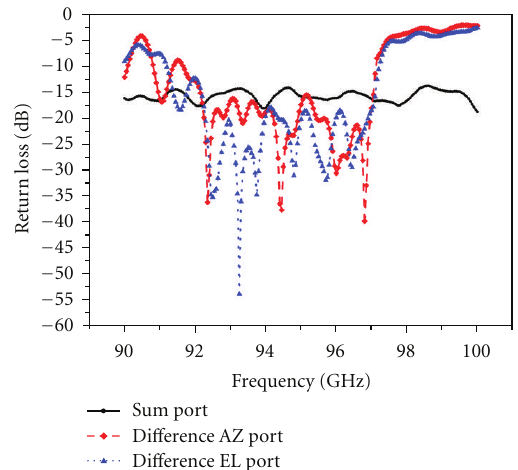
Figure 10: Measured return loss of the sum-di ff erence device with horn.